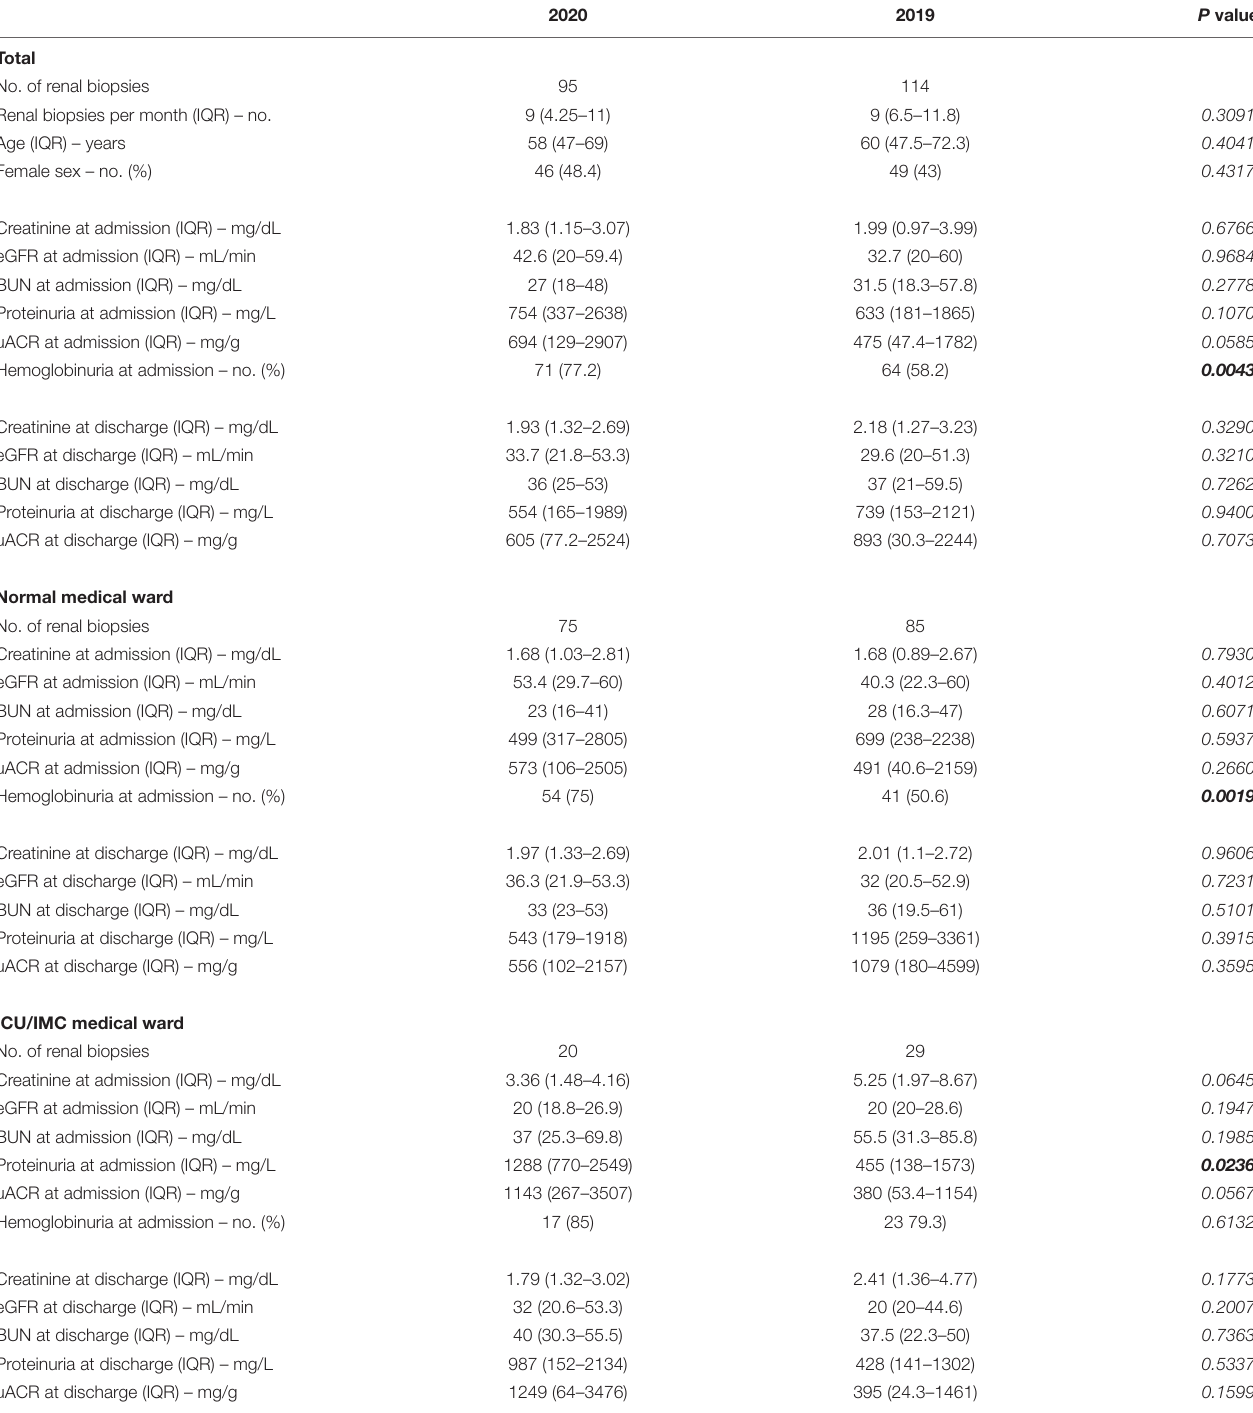
TABLE 2 | Renal biopsies and characteristics of patients comparing 2020 with